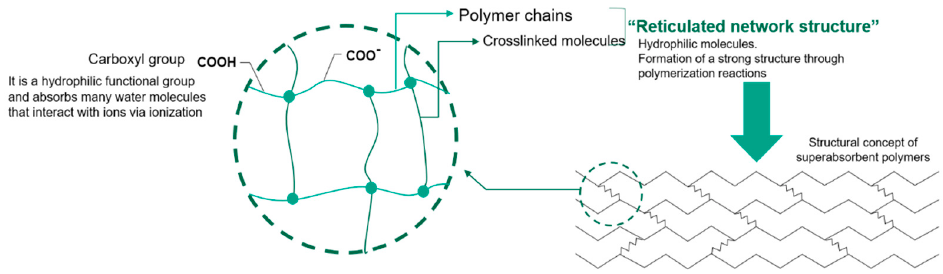
Figure 3. The water absorption principle of superabsorbent polymers.